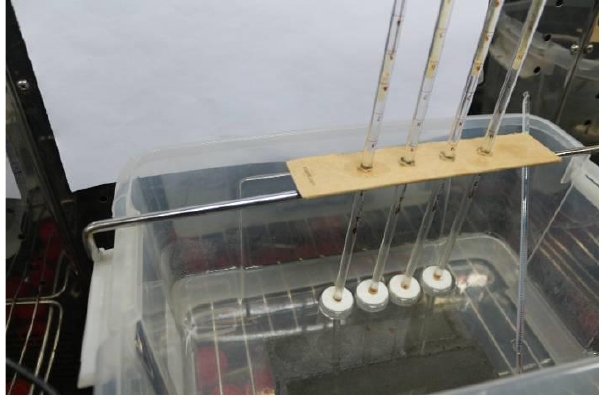
Figure 2. Photo of the chemical shrinkage test device.